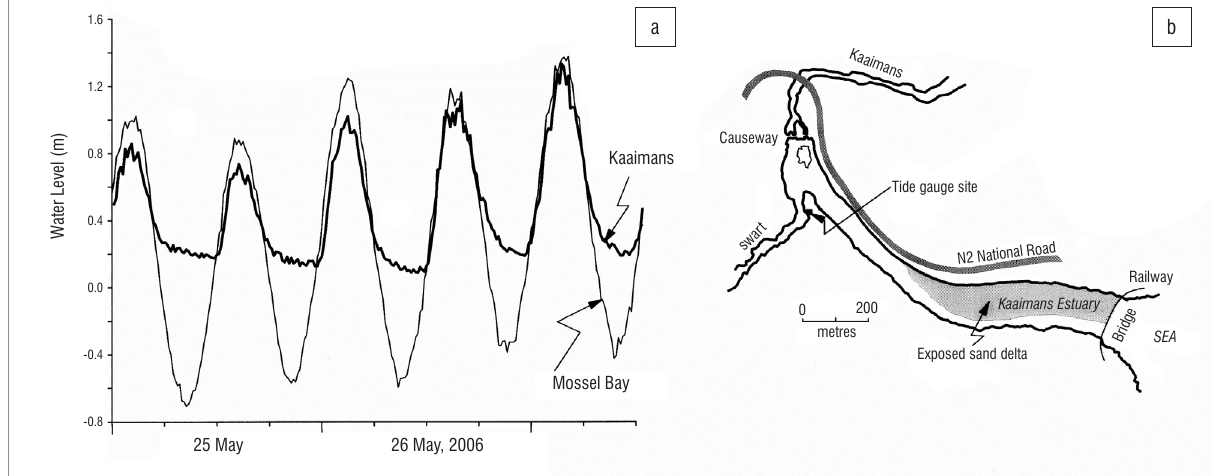
Figure 4: (a) Water level variability in the Kaaimans Estuary (dark line) and at the nearby port of Mossel Bay (light line). (b) A map showing the morphology of the estuary and position of the measuring site.